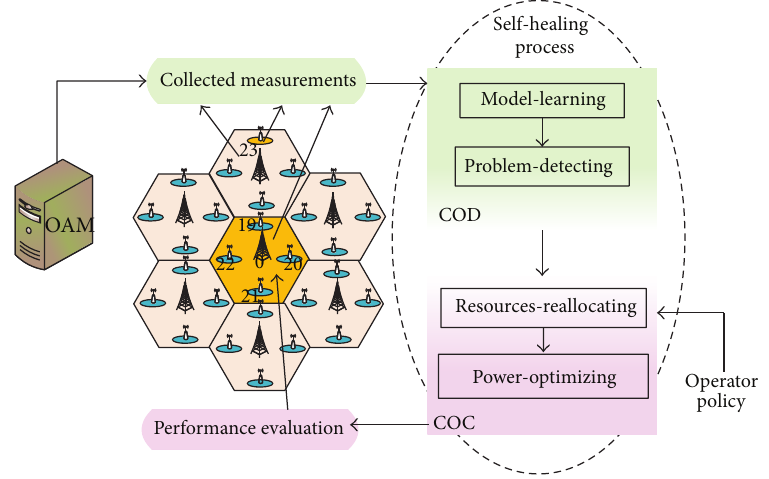
Figure 1: System model for self-healing mechanism in heterogeneous macropico